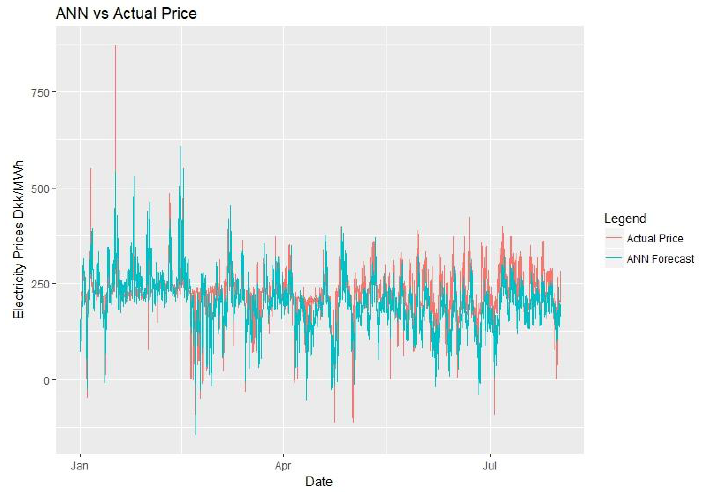
Figure 20. Artificial neural network vs. Actual price.